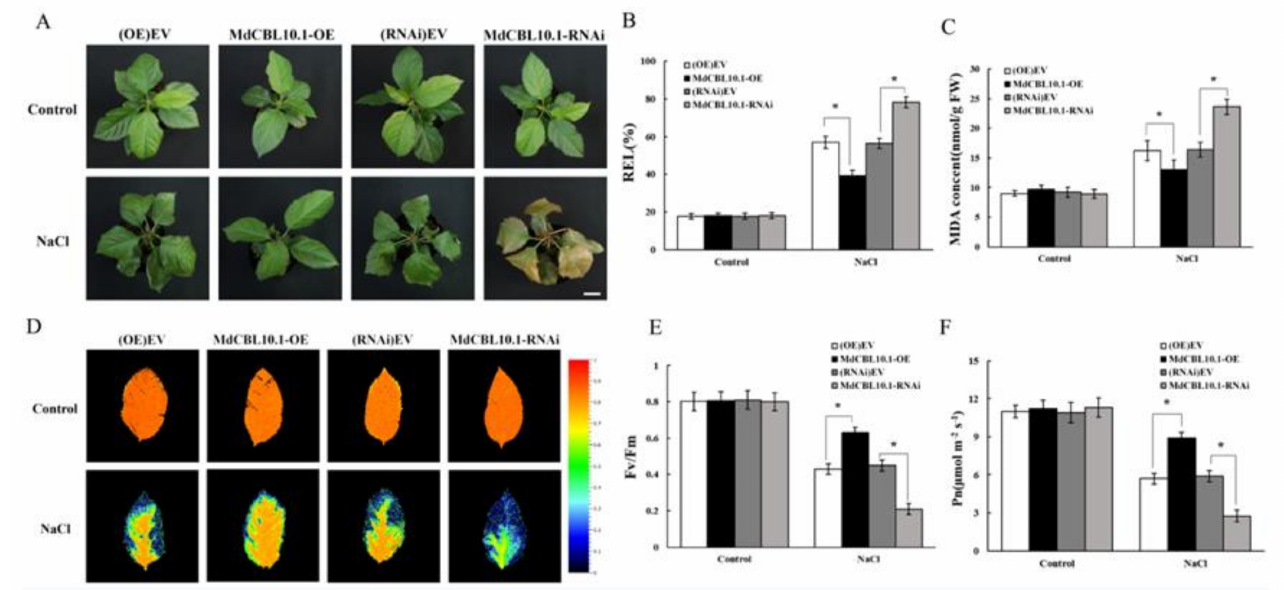
Figure 6. Phenotypic analysis of MdCBL10.1 cisgenic apple plants under 150 mM NaCl treatment. ( A ) Growth phenotypes of cisgenic apple plants after NaCl treatment. Scale bars represent 3 cm. ( B ) Relative electrolyte leakage (REL) of apple leaves. ( C ) Malondialdehyde (MDA) content in apple leaves. Representative chlorophyll fluorescence images ( D ), Fv/Fm ratios ( E ), and net photosynthetic rate (Pn) ( F ) of cisgenic apple plants under normal and NaCl stress conditions. (OE)-EV and (RNAi)-EV represent roots transformed with the empty vector pCambia2300 and pK7GWIWG2D, respectively. The values of each index for cisgenic plants of the same type are the average values from all lines. Values are means of 20 replicates ± SD (each plant acts as a biological replicate). * in each panel denotes values significantly different from the corresponding control lines ( p < 0.05, Student t